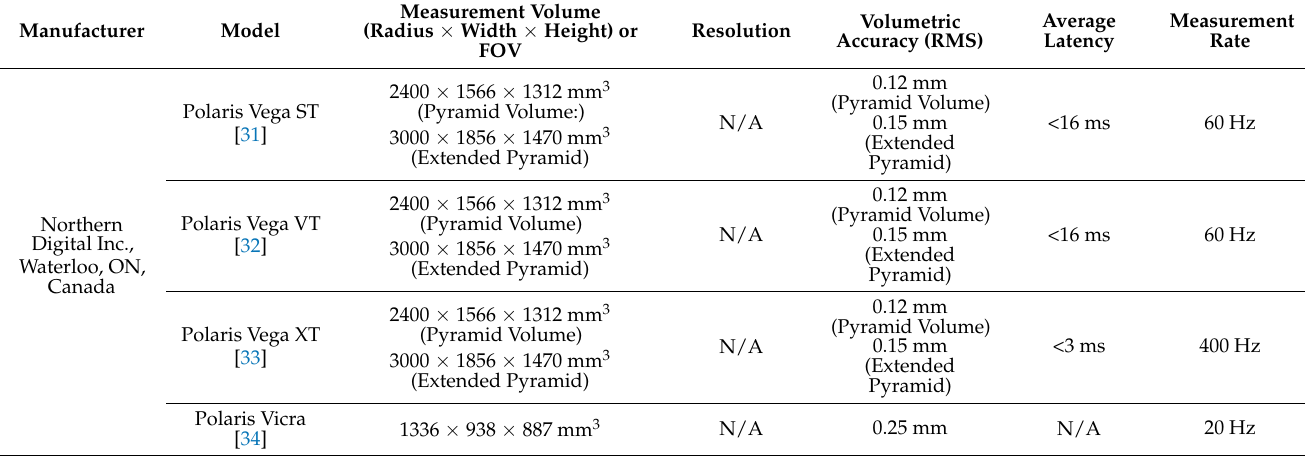
Table 1. Summary of commercially available optical tracking